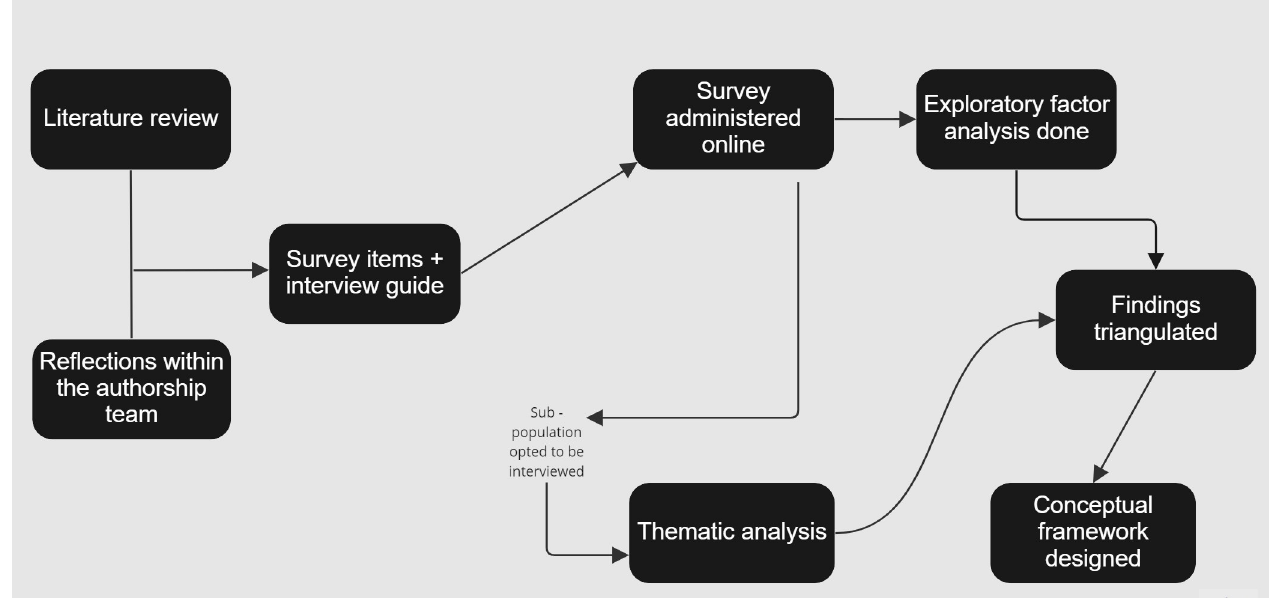
Fig 1. A summary of the